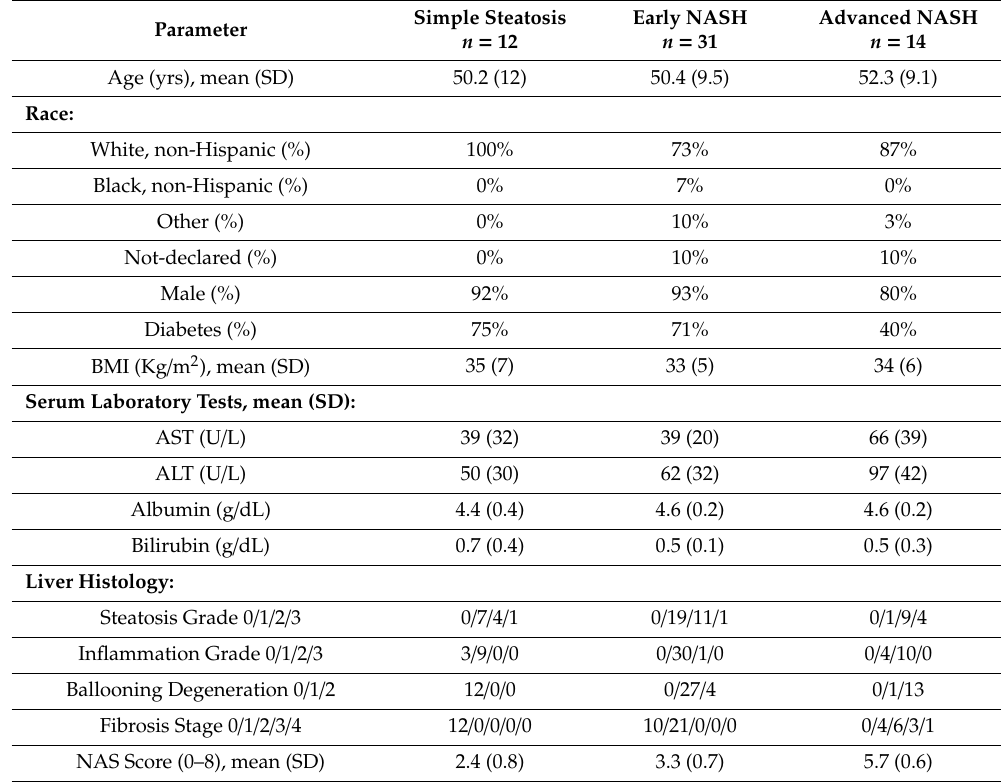
Table 1. Demographic and clinical characteristics of study participants divided according to histological severity of nonalcoholic fatty liver disease (NAFLD) (simple steatosis, early-nonalcoholic steatohepatitis (NASH),